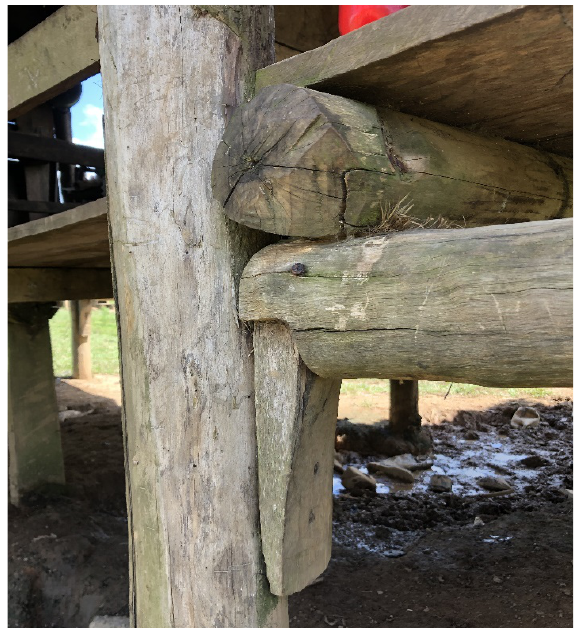
Figure 5. Detail of the structure of the main slab. Santa María, Bonanza (Nathalia